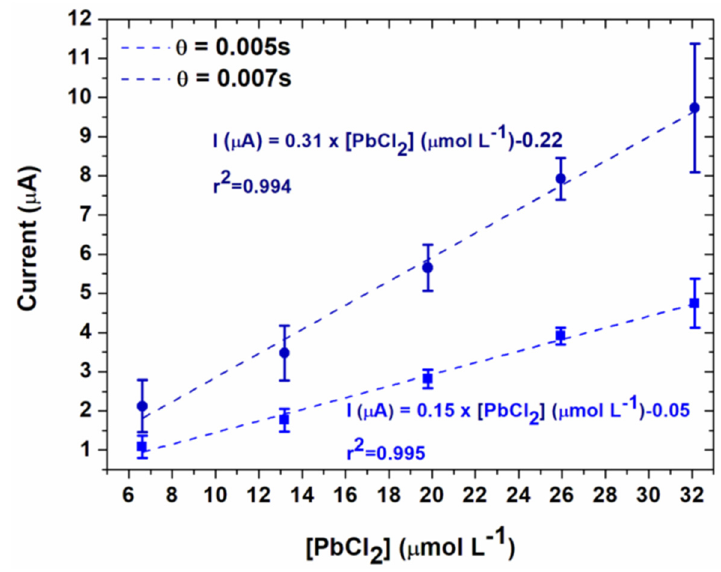
Figure 10. Calibration curves obtained for two sampling times, for chronoamperometry performed at 0.07 V/SCE in 0.1 mol L − 1 NaCl (electrodeposition conditions: E d = − 0.5 V/SCE, t d = 90 s).